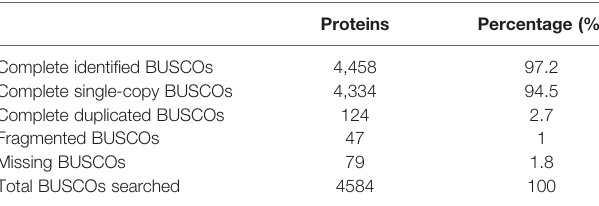
TABLE 2 | BUSCO analysis to validate the completeness of the genome assembly.